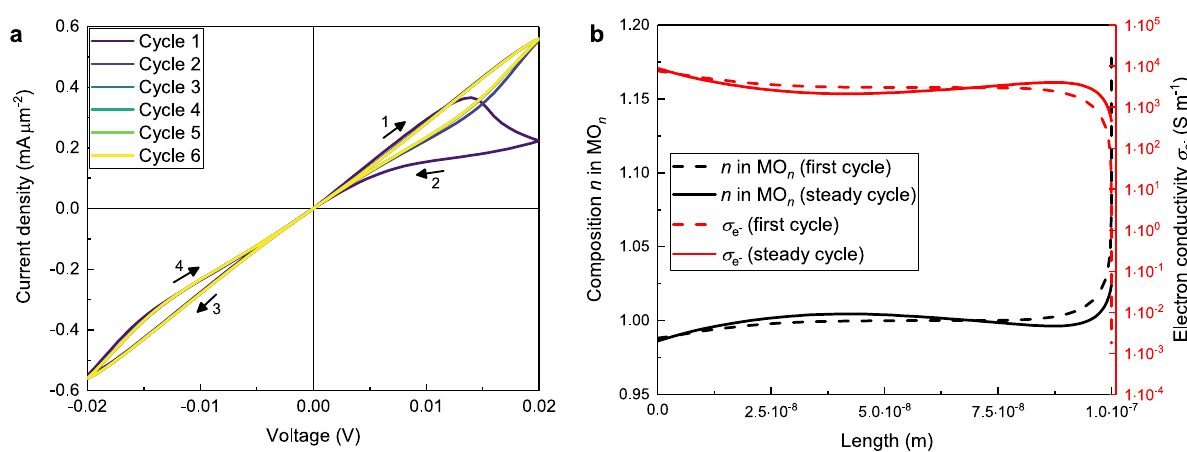
Figure 3. 1D-simulation with basic parameters (see Table 1). ( a ) The first six cycles of the I – V curve are displayed and show abnormal bipolar resistive switching. The numbered arrows indicate the temporal development, which is identical for all cycles. ( b ) Composition profiles (black) and electronic conductivity profiles (note the log-scale for the conductivity in red) after one quarter of a cycle when the maximum voltage is applied. The dotted lines indicate the first cycle while the solid lines indicate the steady cycles. The bottom electrode is on the left side, while the top electrode is on the right